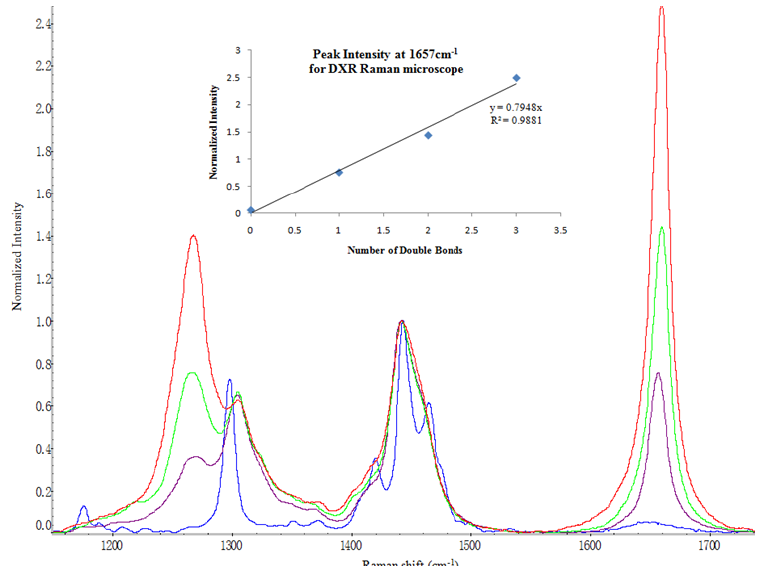
Fig. 1. Raman Spectra of stearic acid(blue), oleic acid(purple), linoleic acid(green), and linolenic acid(red) Inset: Calibration curve of –C=C- count at 1657